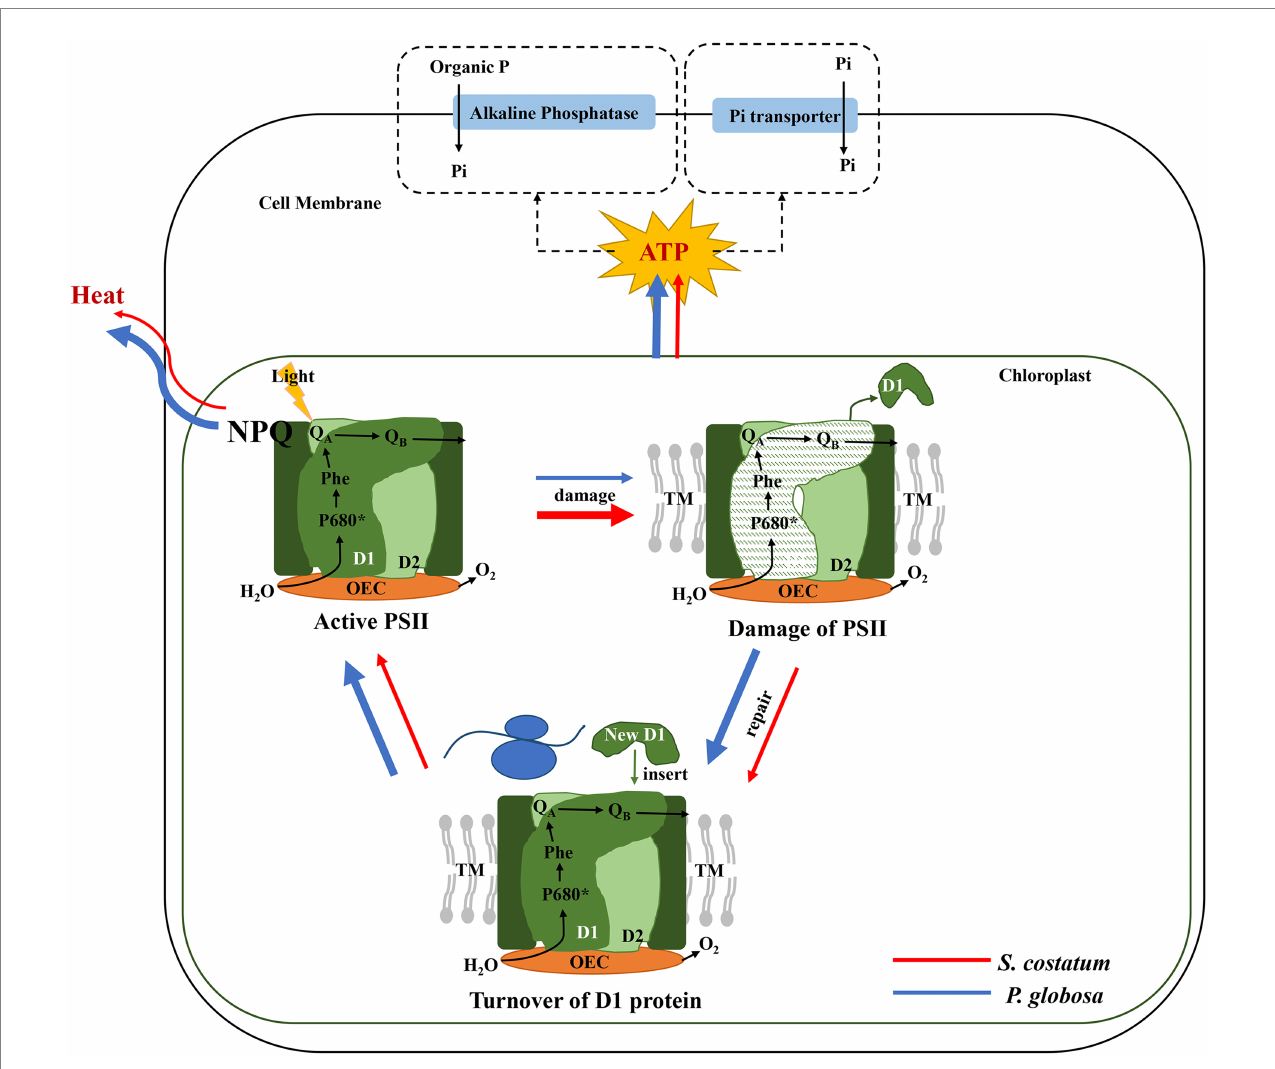
FIGURE 11 The photosynthetic responses of S . costatum (red line) and P . globosa (blue line) under P limitation (the thickness of the line indicates the strength of the